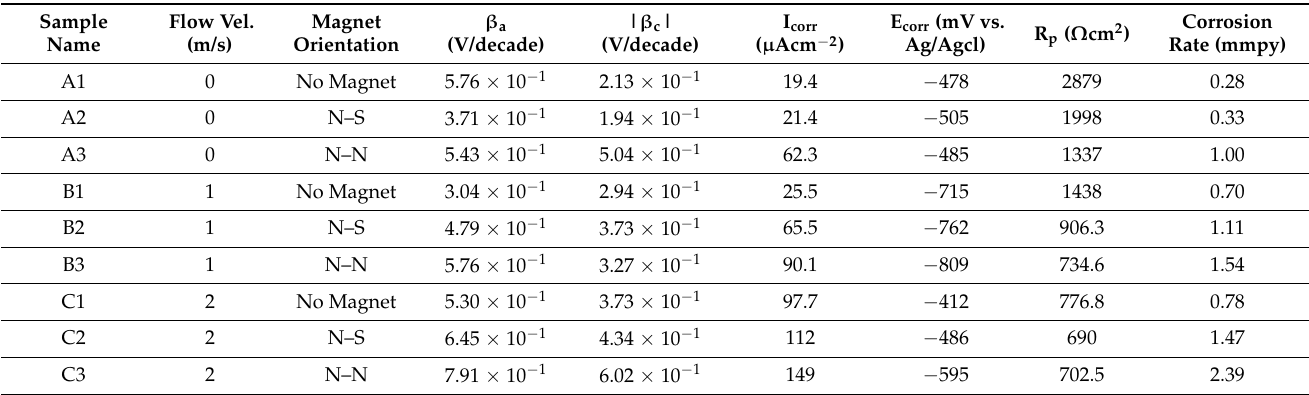
Table 2. Polarization